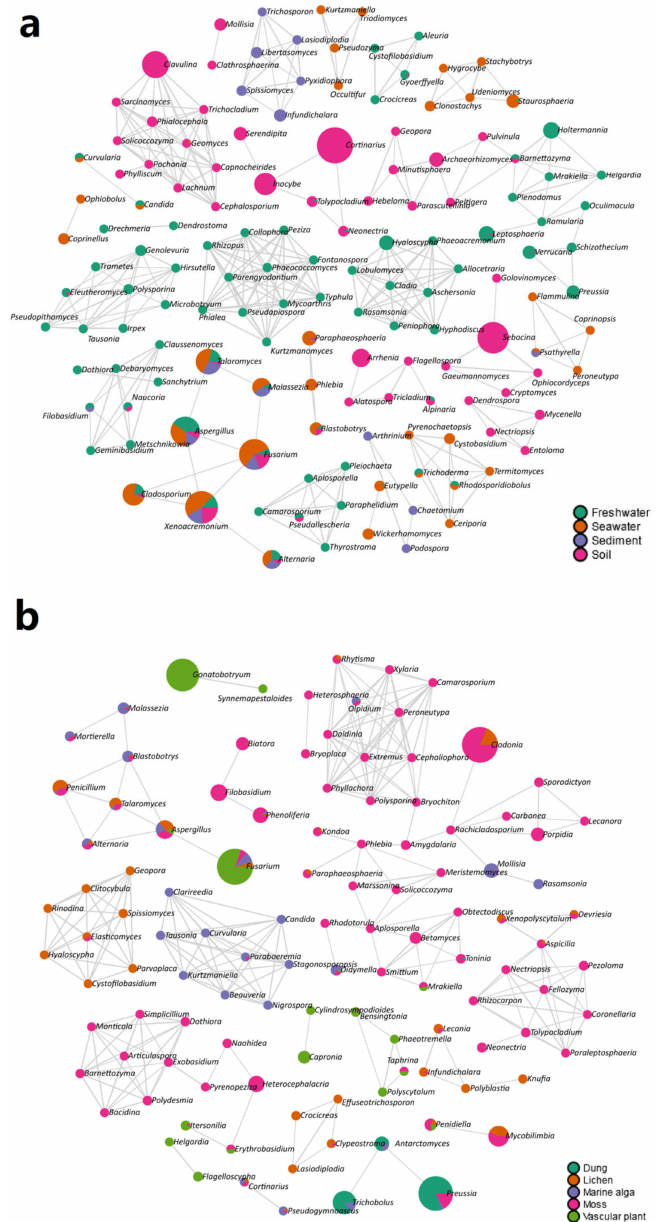
Figure 4. Correlation network analyses showing the correlations of the fungal genera in ( a ) four habitat types (i.e., freshwater, seawater, sediment, and soil) and ( b ) five habitat types (i.e., dung, lichen, marine alga, moss, and vascular plant). Each node represents taxa at the genus level and the edges represent correlations between taxa pairs. The nodes are colored based on habitat